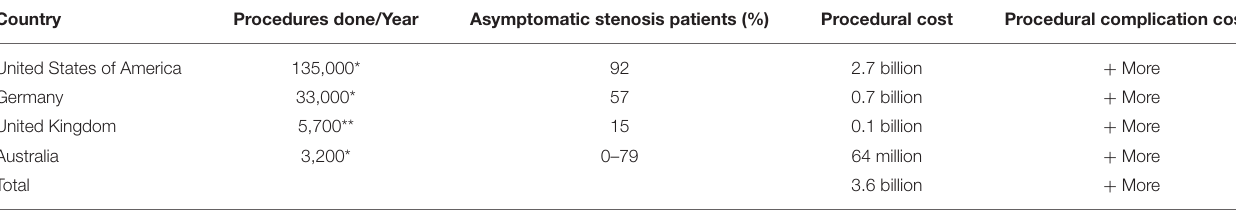
TABLE 1 | The multi-billion dollar per year global carotid procedural industry (29–34). Country